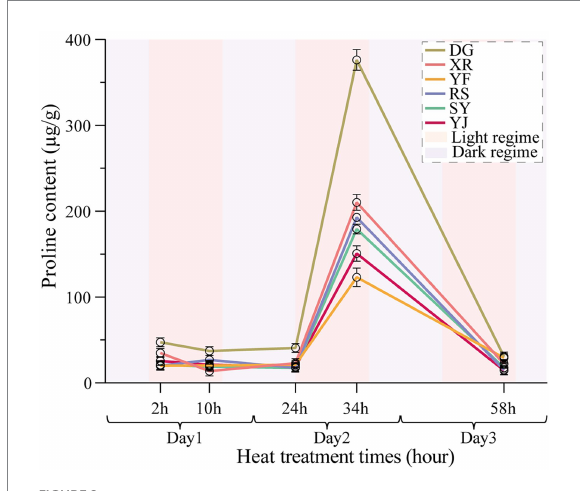
FIGURE 2 Effects of heat stress on B. luminifera populations’ pro contents under different temperature treatments